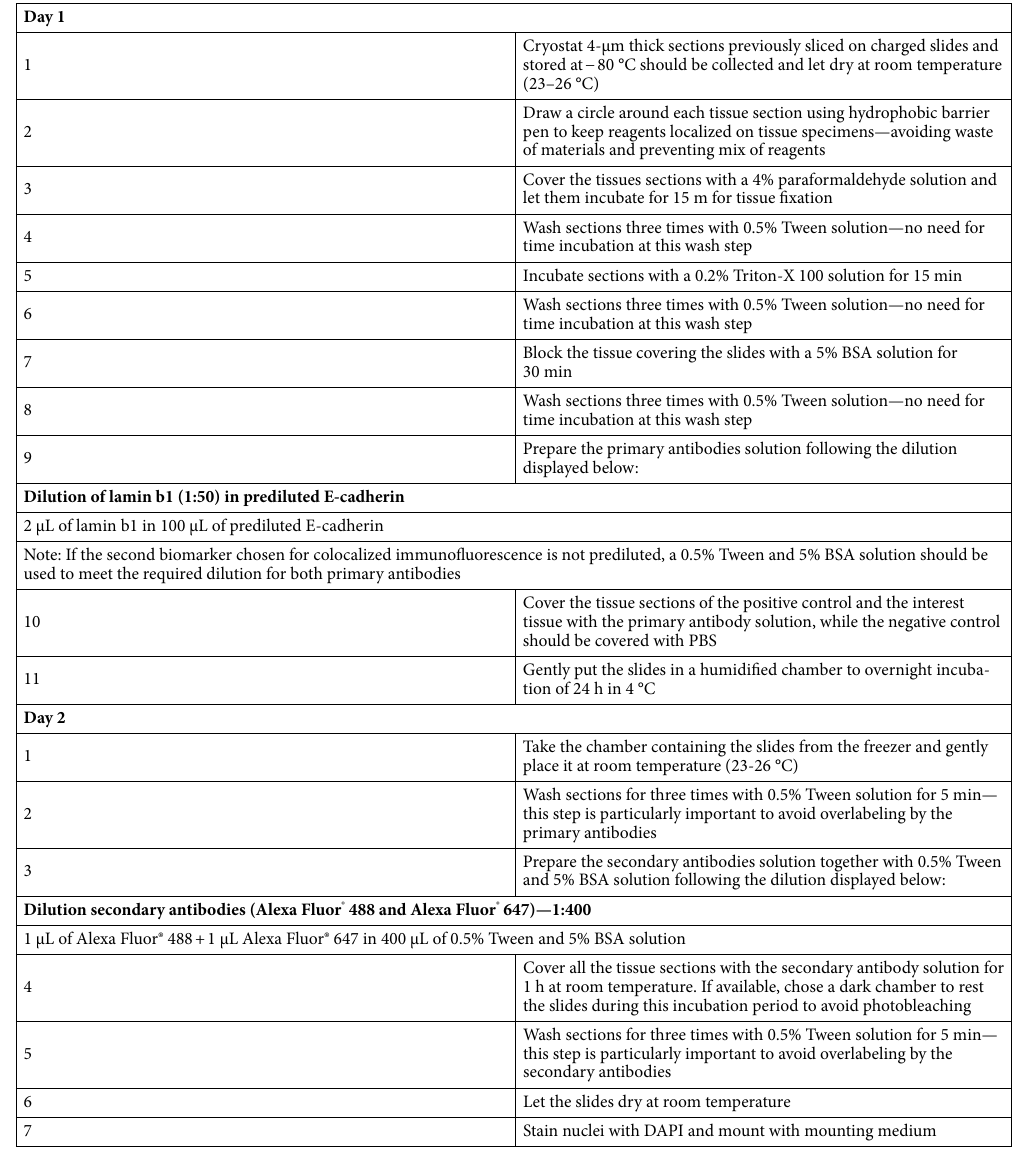
Table 2. Lamin b1 immunofluorescence staining protocol for endometriosis